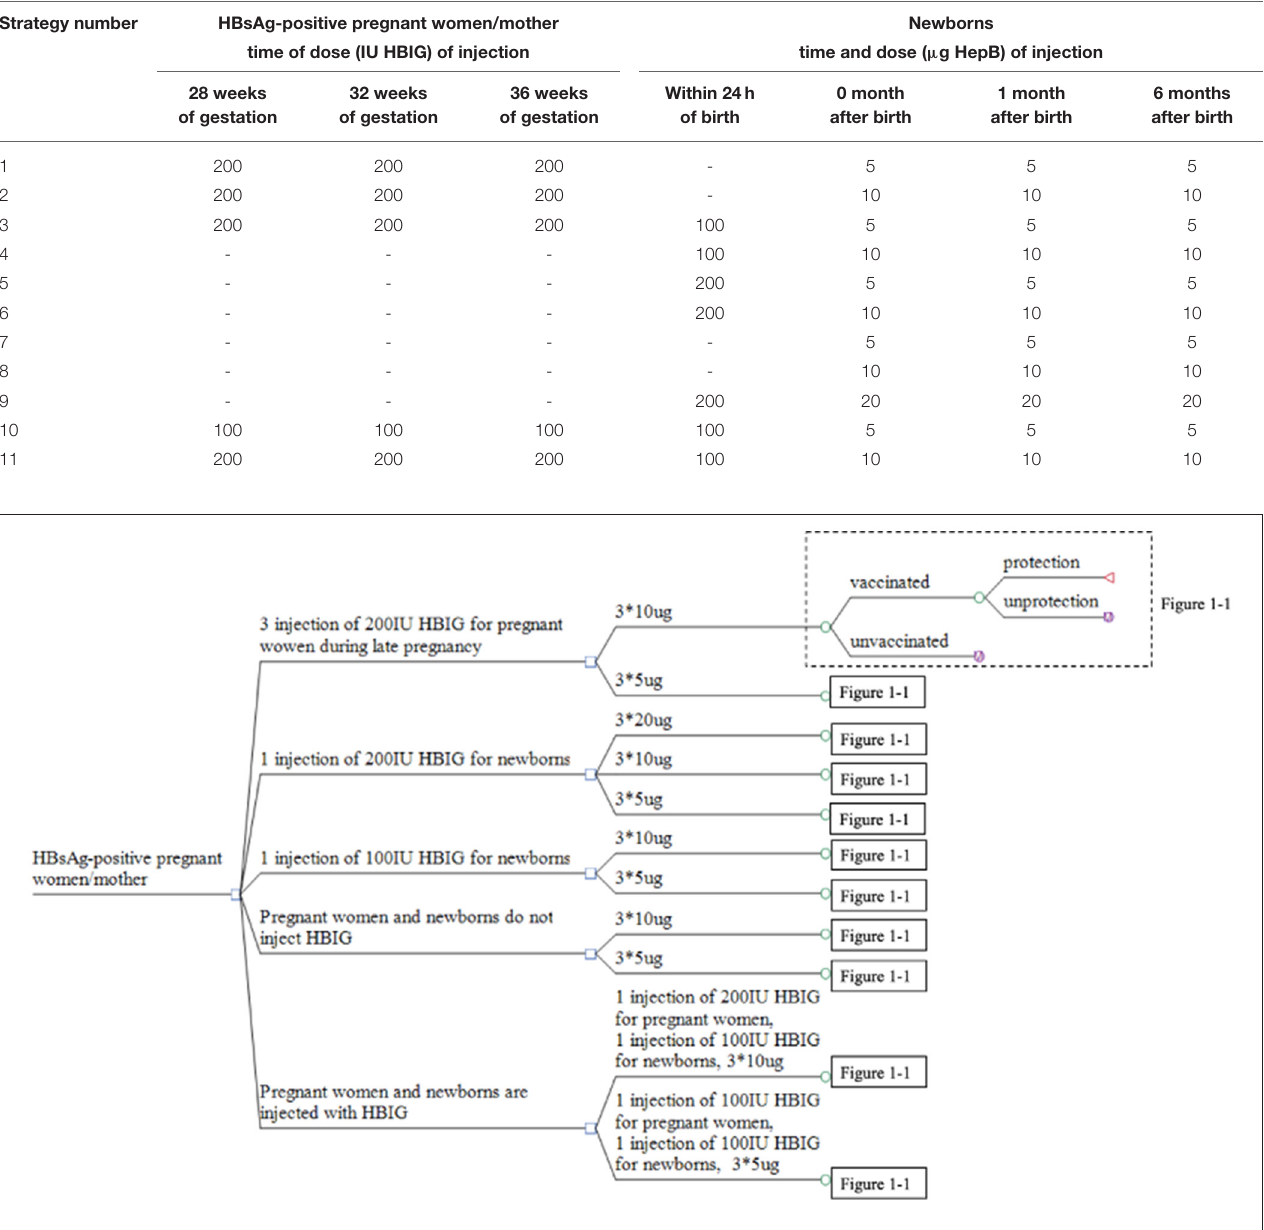
FIGURE 1 | Decision tree for the strategies used to prevent MTCT of HBV. *Represents time of